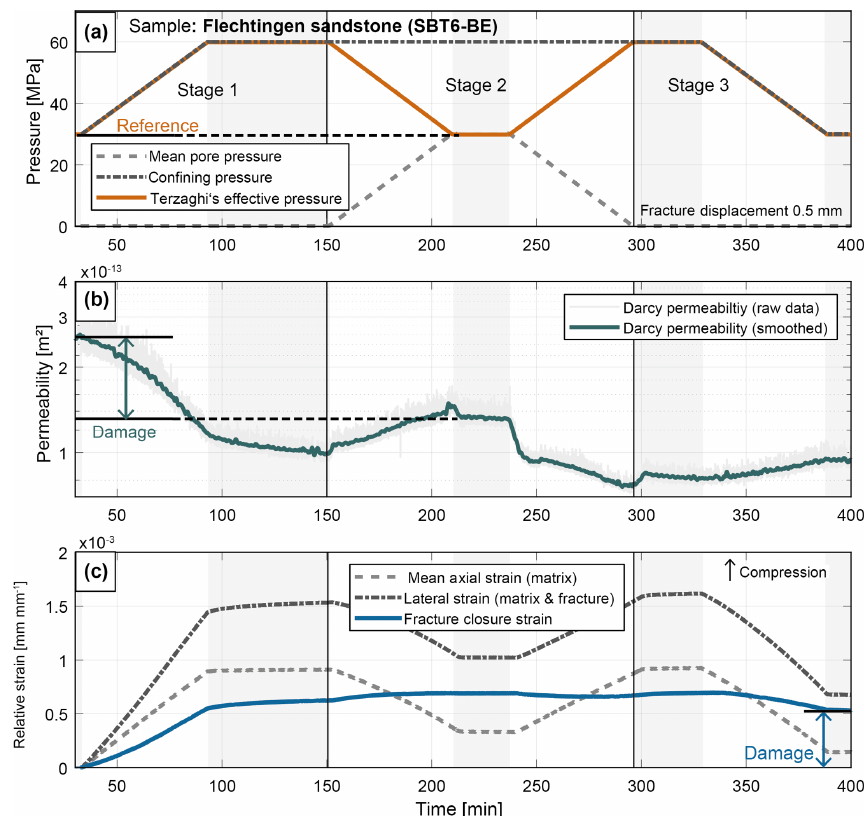
Figure 2. (a) Experimental procedure and effective stress changes, (b) sample permeability evolution, (c) fracture closure strain evolution.